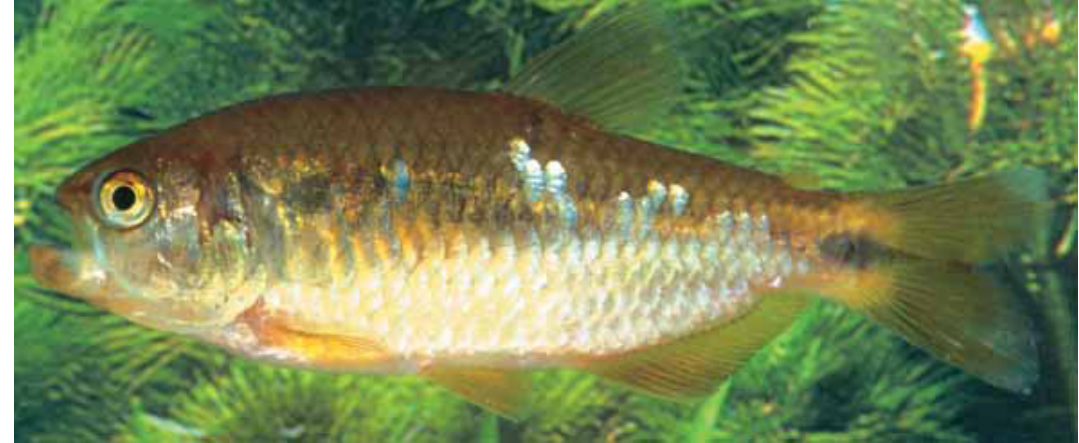
Fig. 2. Hyphessobrycon langeanii , paratype, MZUSP 73313, 58.4 mm SL, Brazil, Mato Grosso, município de Alto Araguaia, córrego Mosquito. Photographed in life.